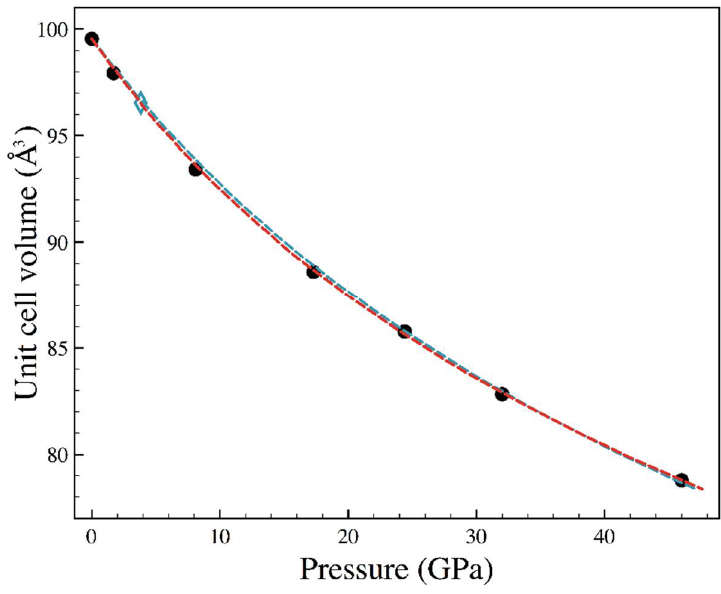
Figure 3. Relative compression of the orthorhombic unit-cell edges. Table 2. Unit-cell parameters and atomic fractional coordinates of ferroselite at high